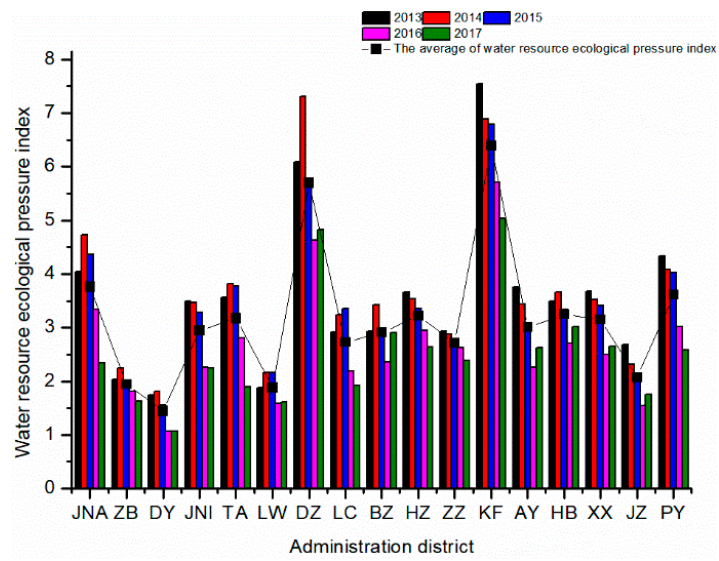
Figure 10. Water resources ecological pressure index of the Lower Yellow River in 2013–2017.